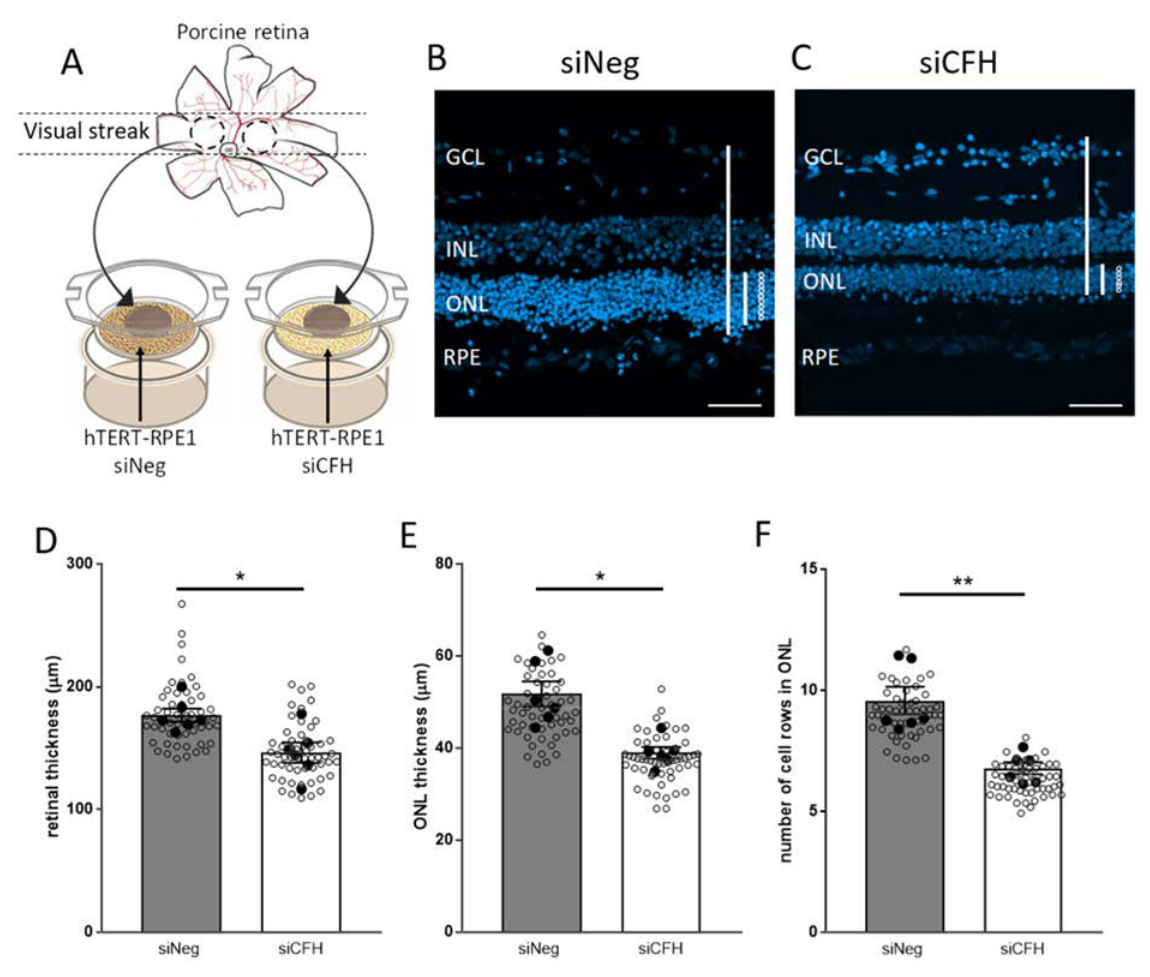
Figure 1. FH loss mediates changes in the co-cultured porcine retina. ( A ) Schematic representation of the co-culture system, in which two retinal explants from the visual streak of porcine donor eyes are exposed to either siNeg or siCFH hTERT-RPE1 cells for 72 h. ( B , C ) The porcine retinal architecture was assessed with the help of DAPI, a nuclear staining dye. Representative images of siNeg co-culture ( B ) and siCFH co-culture ( C ) are shown. Lines and circles highlight the parameters extrapolated from these images and quantified in ( D – F ) the overall thickness of the porcine retina ( D ), the thickness of the ONL ( E ) and the number of rows in the ONL ( F ). Abbreviations: GCL—Ganglion cell layer, INL—inner nuclear layer, ONL—outer nuclear layer, RPE—retinal pigmented epithelium cells, siNeg—silencing negative control, siCFH—silencing CFH. Mean ± SEM is shown. N = 6 biological replicates. * p ≤ 0.05; ** p ≤ 0.005. Scale bar—50 µ